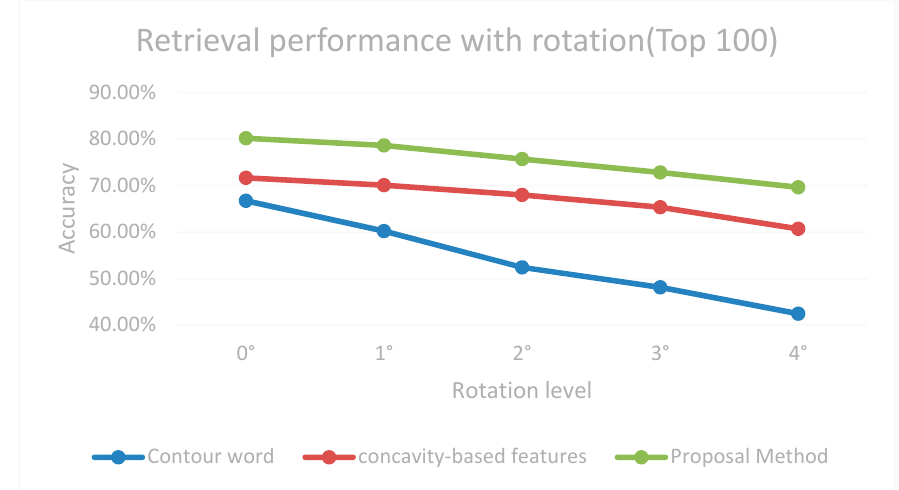
Figure 33. The performance of different rotations.